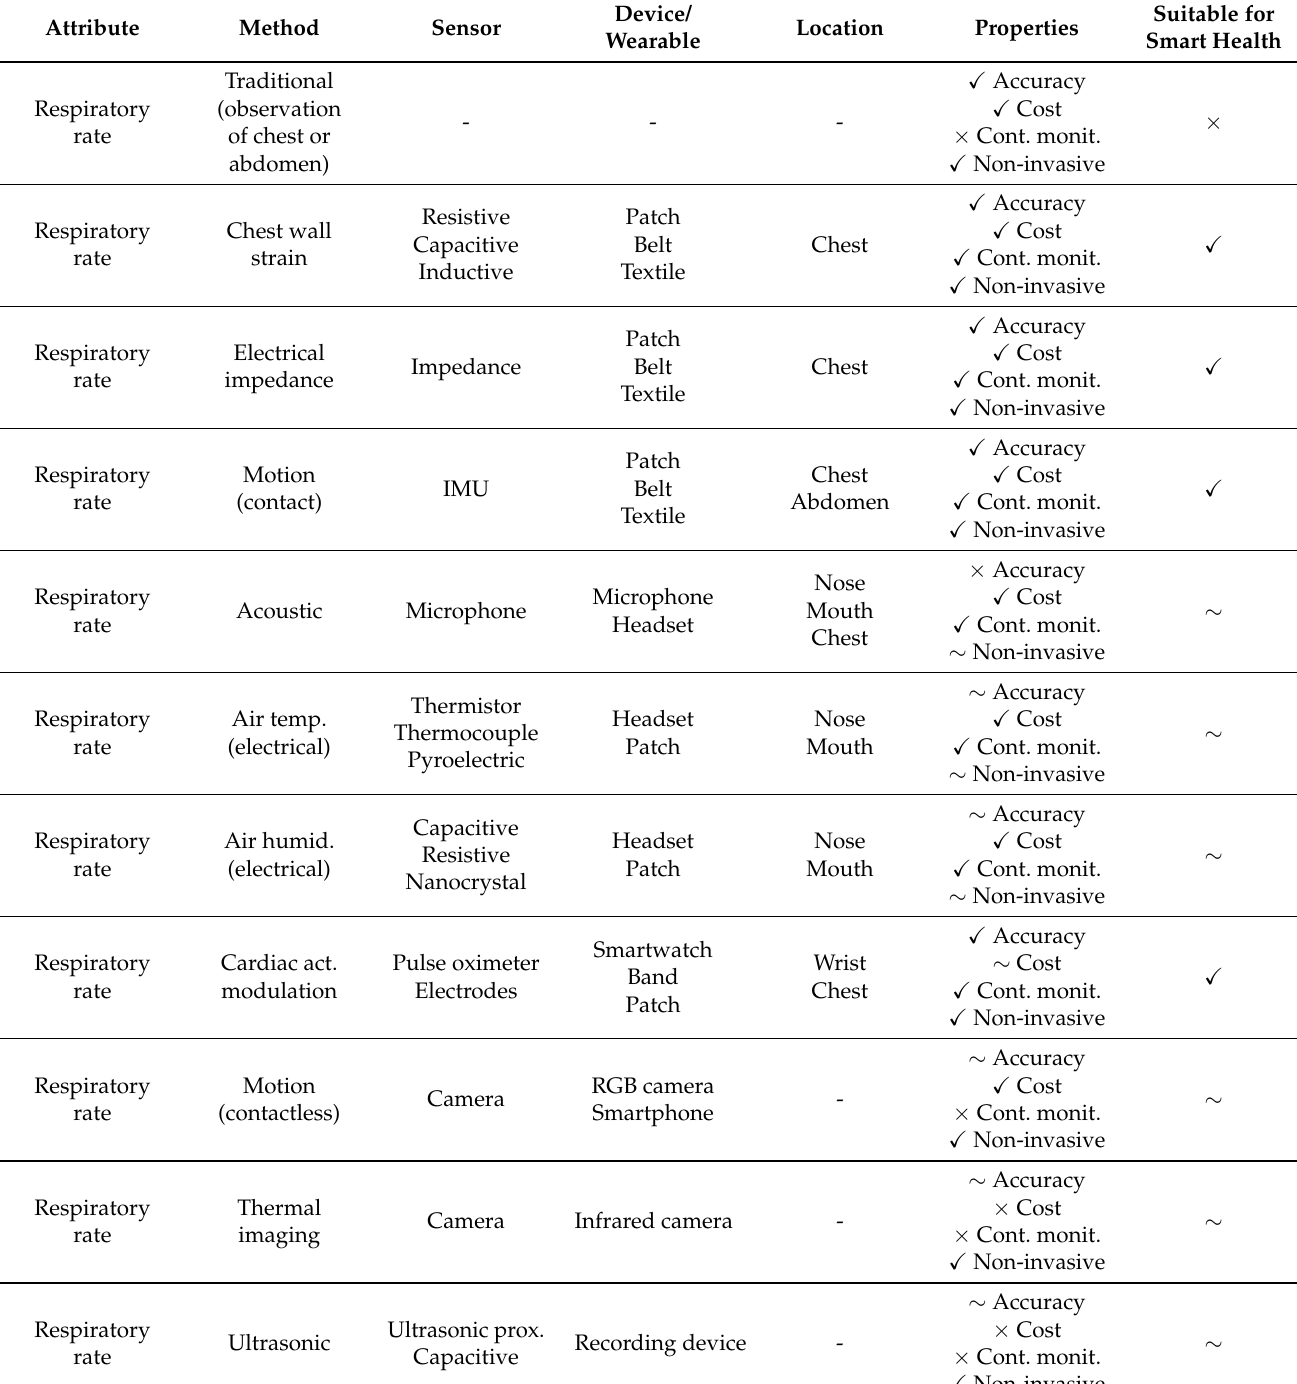
Table 4. Characteristics of the methods for respiratory rate